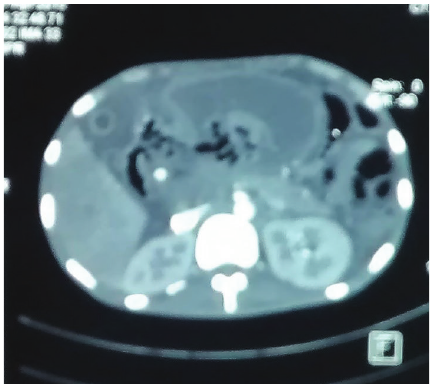
Figure 2: CT abdominal angiography showing gastroduodenal artery aneurysm abutting the wall of the pseudocyst of